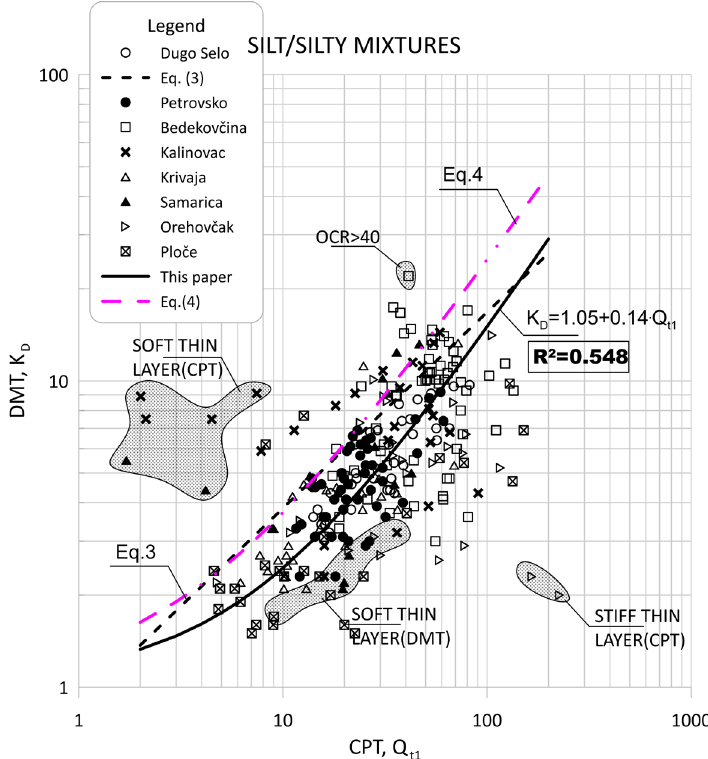
versus 𝑄𝑄 𝑡𝑡1 𝐾𝐾 𝐷𝐷